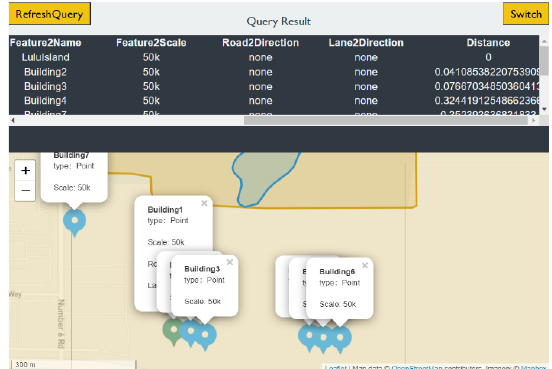
Figure 12 . Result of finding objects that are within 0.5km from Building1. Since LuluIsland contains Building1, the distance in between is